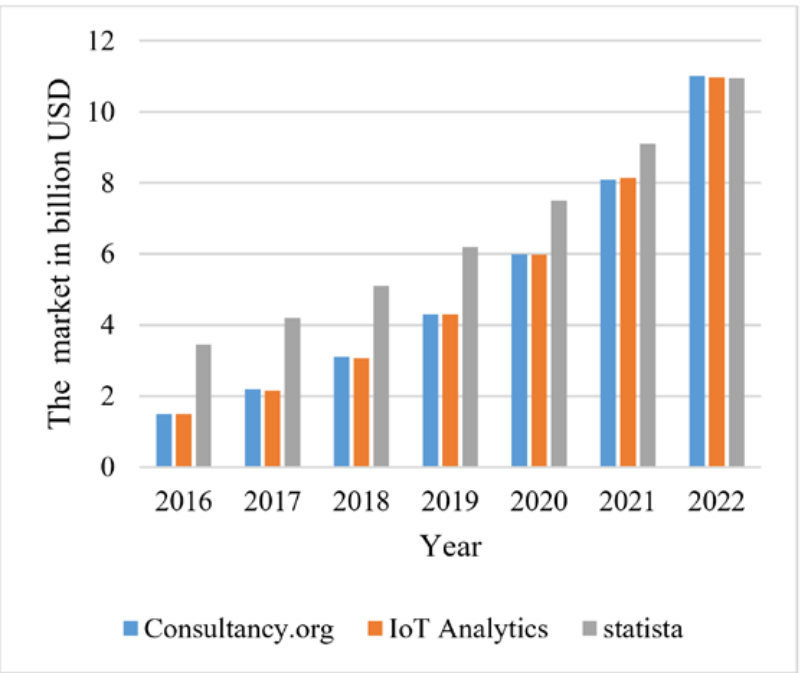
Figure 3. Global market size of PdM-related applications reported by various consulting firms.